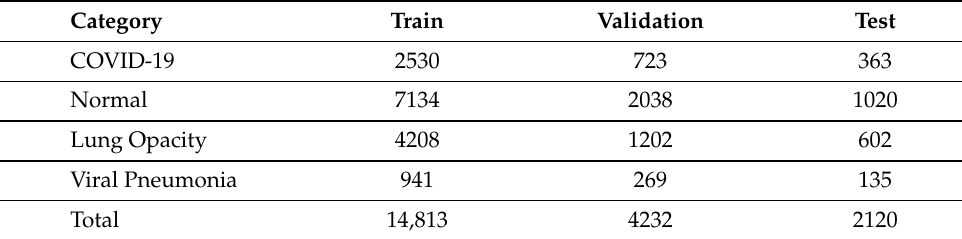
Table 1. The COVID-19 Radiography Database summary used in our